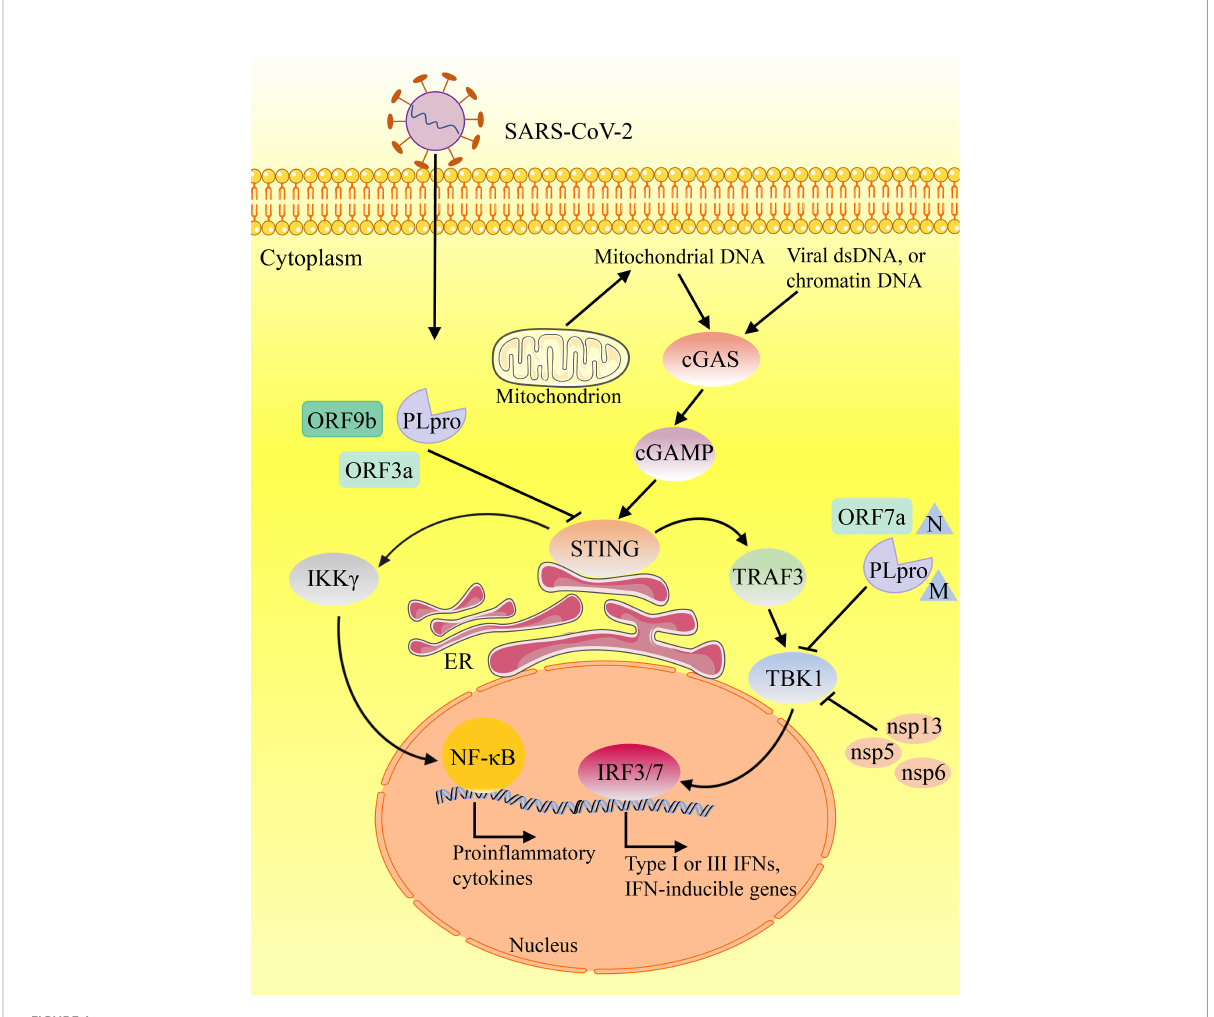
FIGURE 1 The contributing role of STING in innate responses against SARS-CoV-2 infection. SARS-CoV-2 suppresses the components of cGAS-STING pathway, resulting in inhibiting the synthesis and release of various proin fl ammatory cytokines and type I